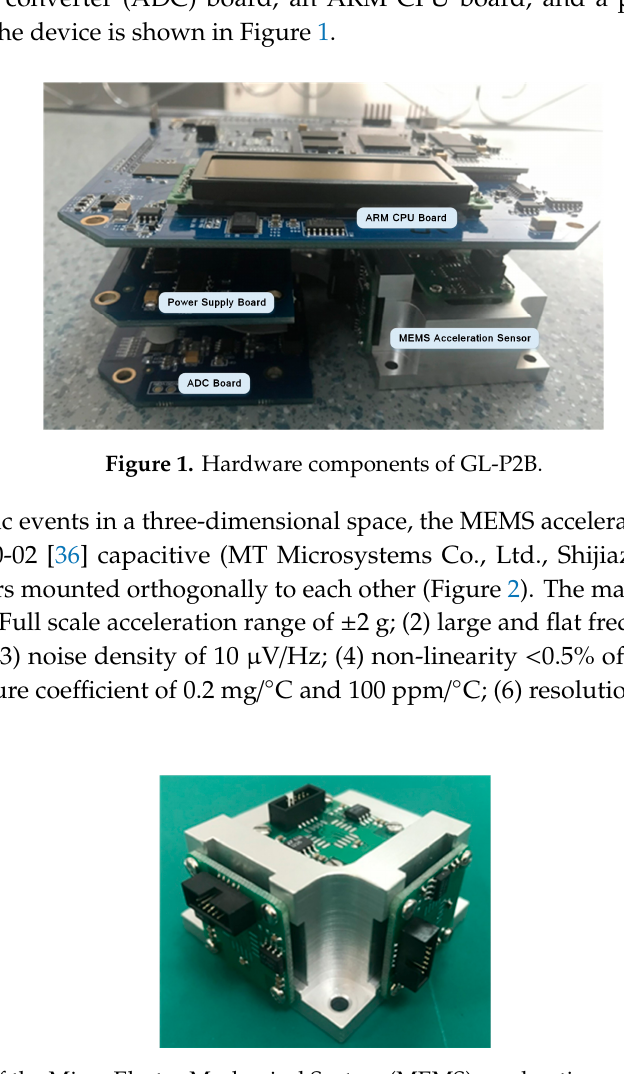
Figure 2. Photo of the Micro Electro Mechanical System (MEMS) acceleration sensor, in which three MSV6000-02 accelerometers are mounted orthogonally to each other.